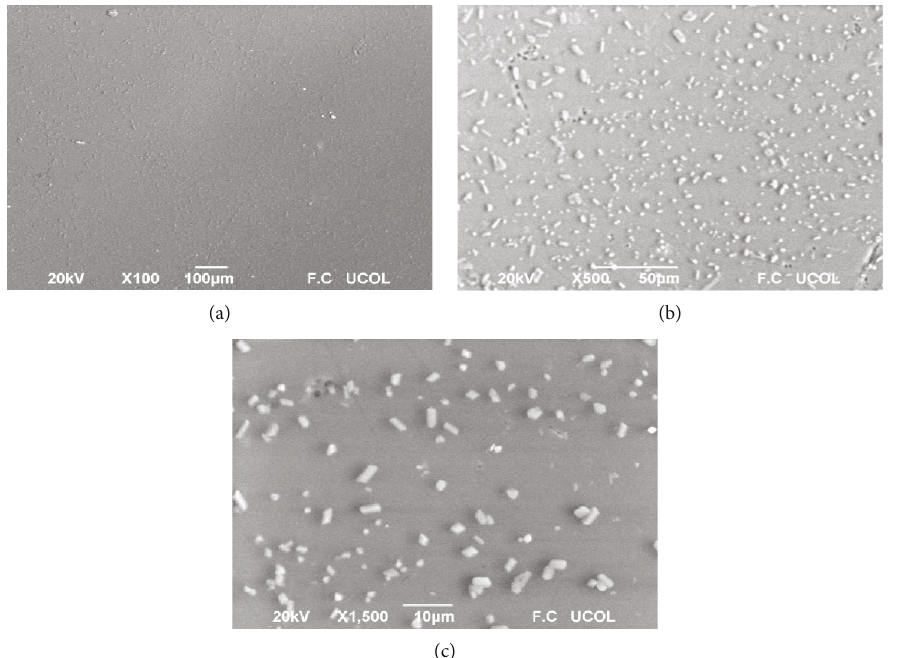
Figure 7: Micrographs of the surface of HPC/PAAm gel with incorporated acetaminophen: (a) 100x, (b) 500x, and (c)